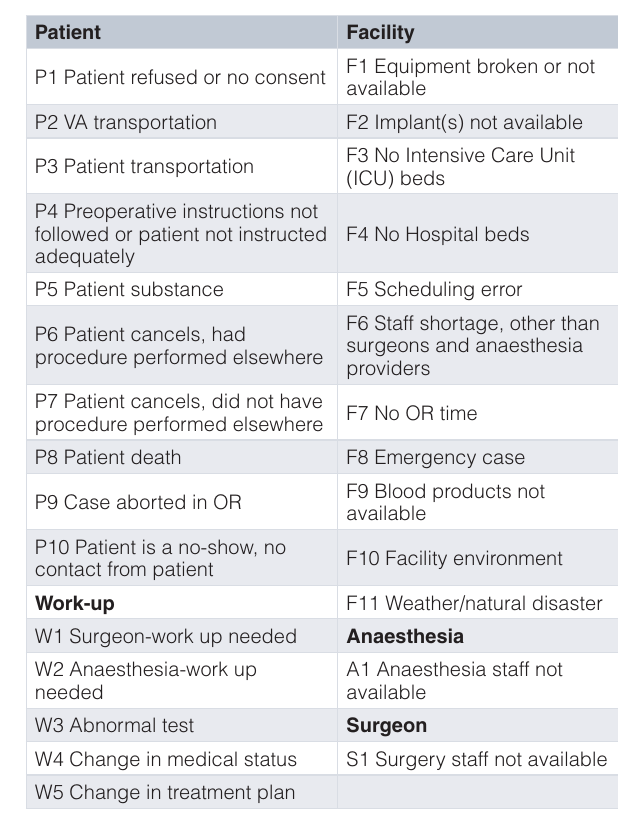
Table 7. Classification of cancellation codes used to group day of surgery (DOS) cancellations. Source: Adapted from: Argo JL, Vick CC, Graham LA, Itani KM, Bishop MJ, Hawn MT. Elective surgical case cancellation in the Veterans Health Administration system: identifying areas for improvement. Am J Surg 2009;198:600–6.